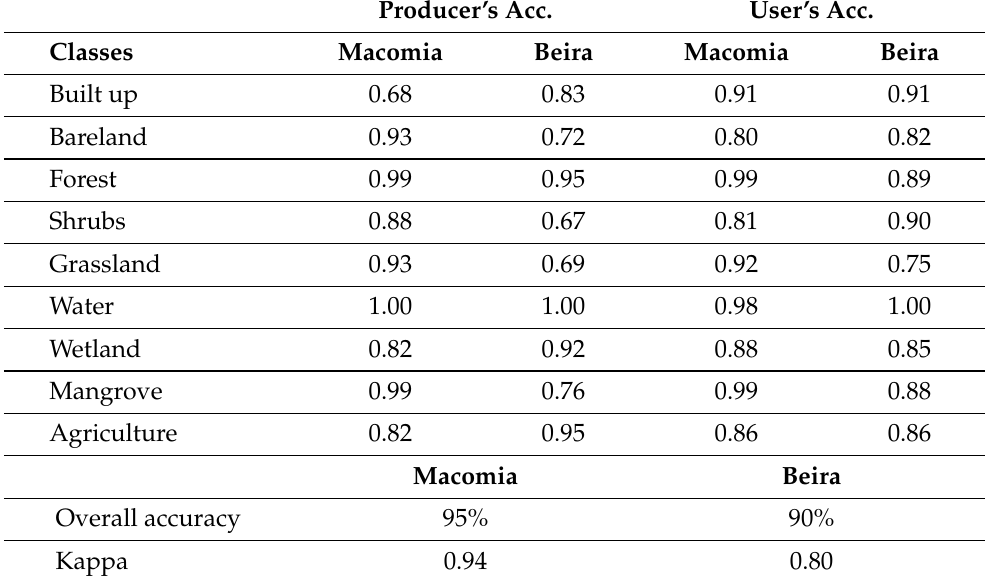
Figure 11. Classification results only for the city of Beira (municipality of Beira) including its 26 neighborhoods. Table 6. Accuracy assessment results for classification in Beira and Macomia, 2019. Producer’s Acc. User’s